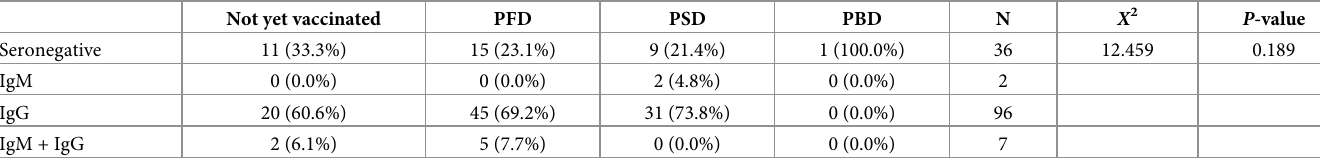
Table 3. Association between seropositivity and vaccine history.